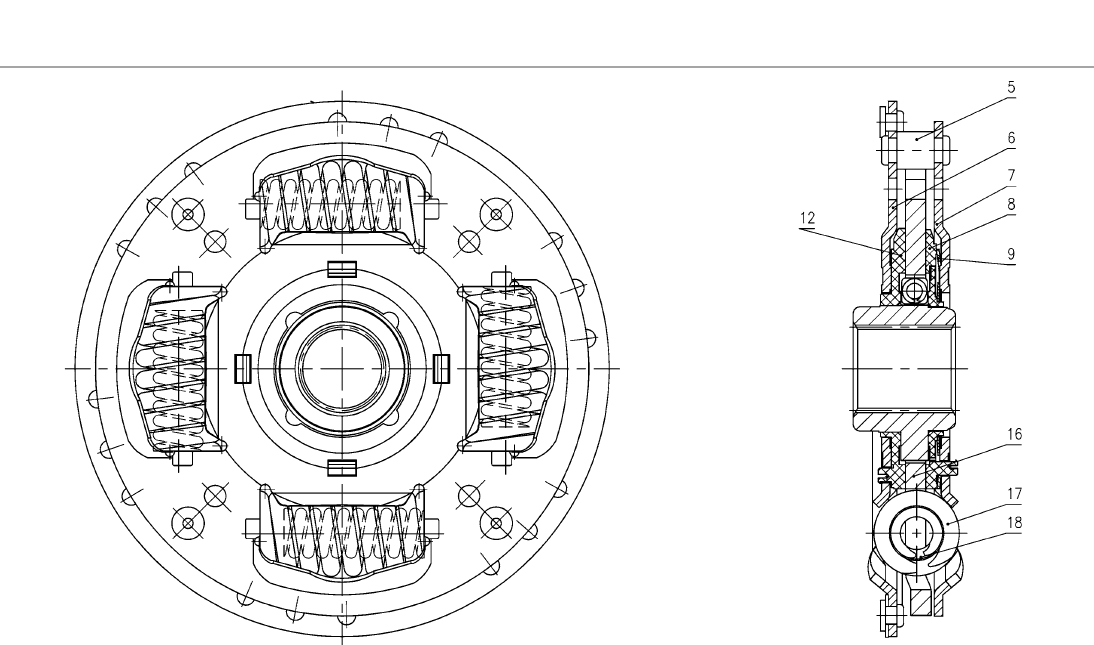
Figure 2 Diagram of idle damping system of traditional clutch-driven disc assembly. 8. Positioning ring, 9. Belleville washer, 10. Positioning ring, 11. Belleville washer, 12. Positioning ring, 13. Spring seat, 14. Spring, 15. Disc hub